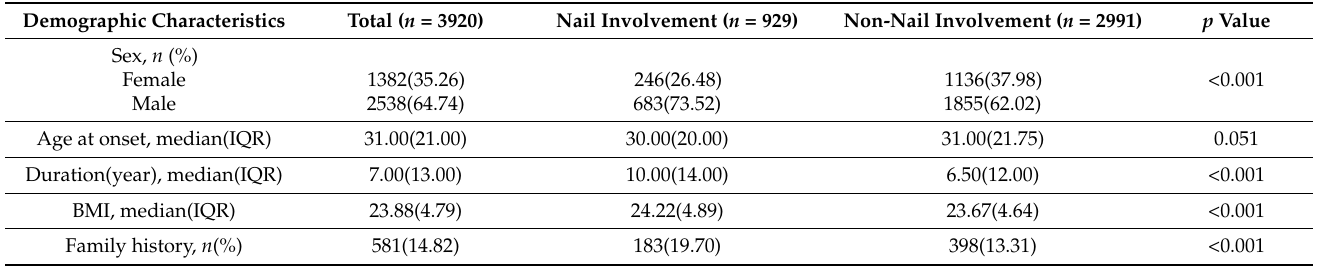
Table 1. Differences between demographic and clinical characteristics of non-nail involvement and nail involvement